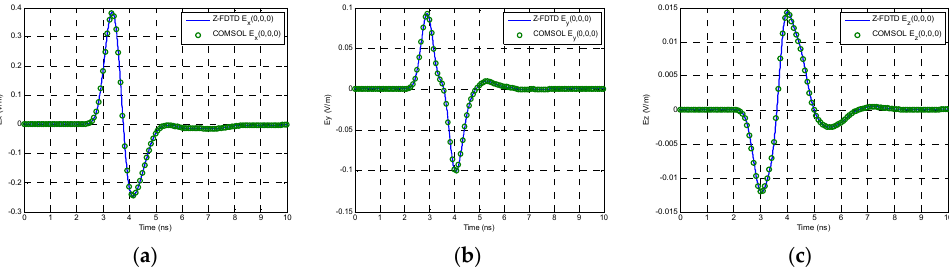
Figure 5. Time-domain results of observation point E (0, 0, 0) when waves propagate through the single brick between 0 and 10 ns: ( a ) E x ; ( b ) E y ; ( c ) E z .